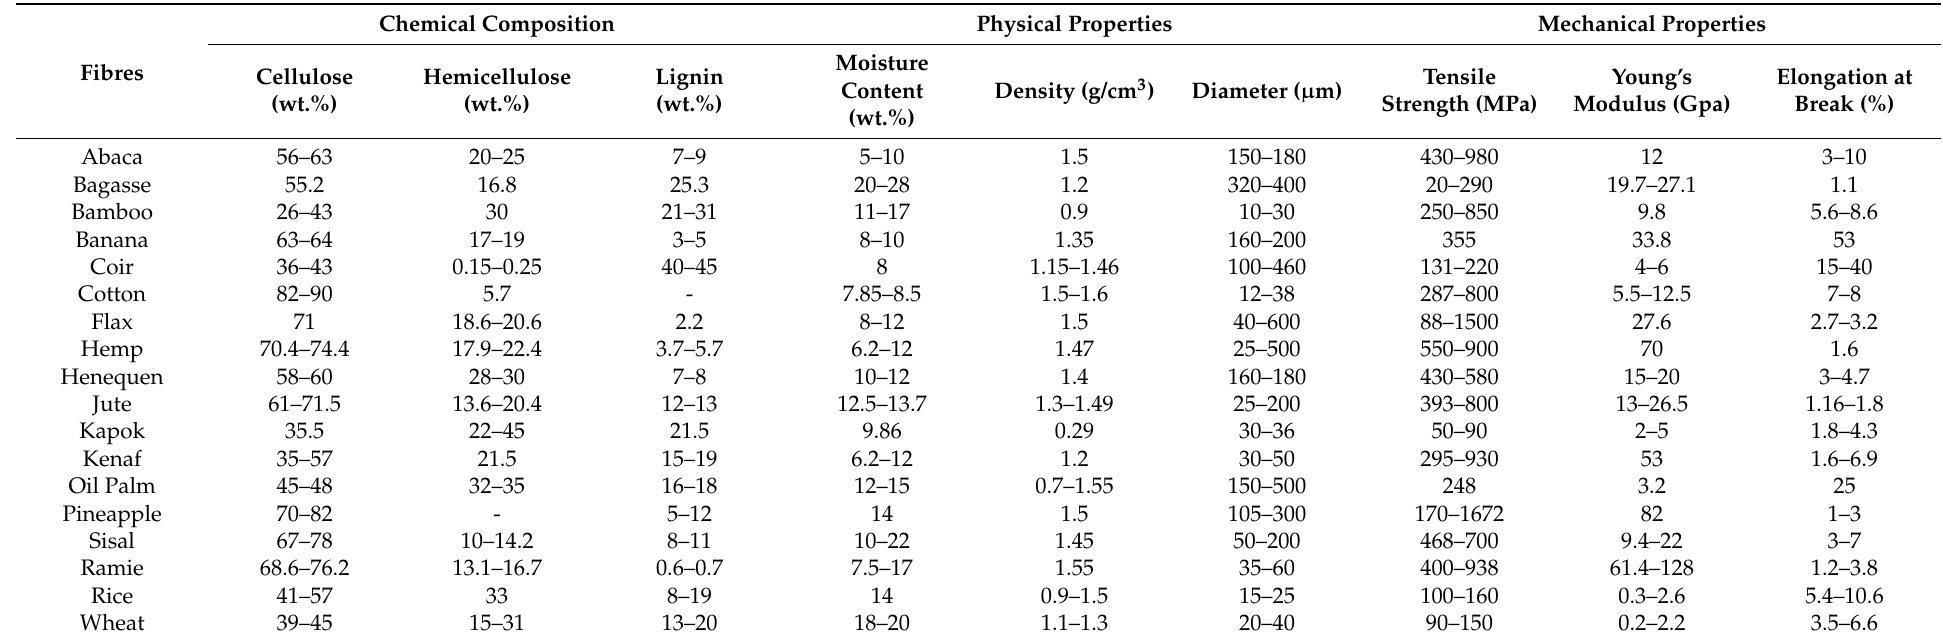
Table 2. Chemical, physical, and mechanical properties of the plant-based or natural cellulosic fibres